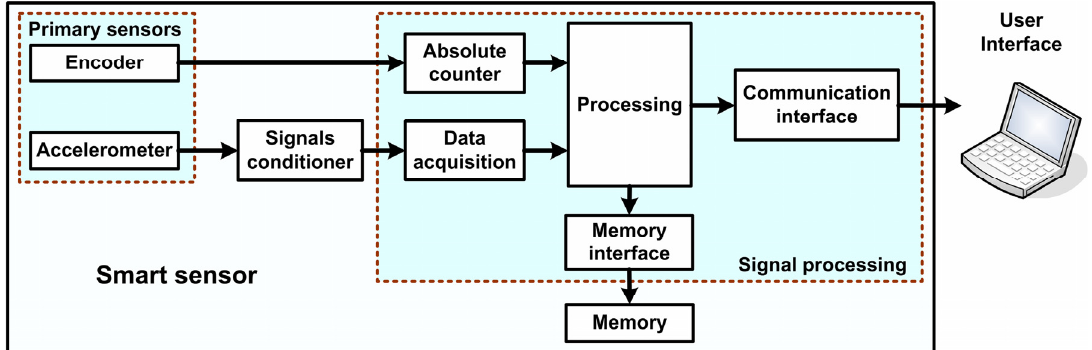
Figure 3. An overview of the architecture of the proposed smart sensor.